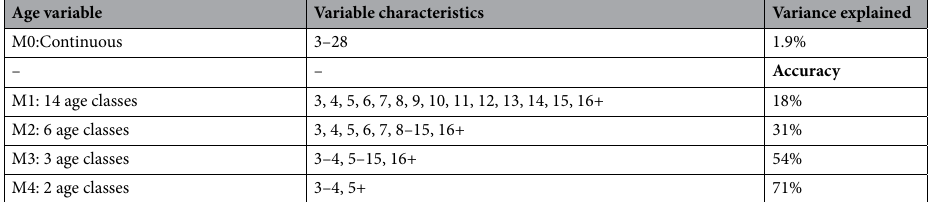
Variable characteristics